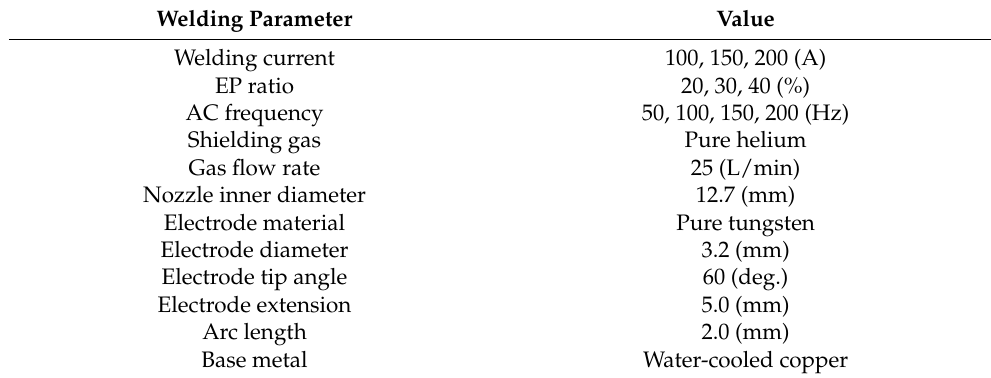
Table 1. Welding conditions.